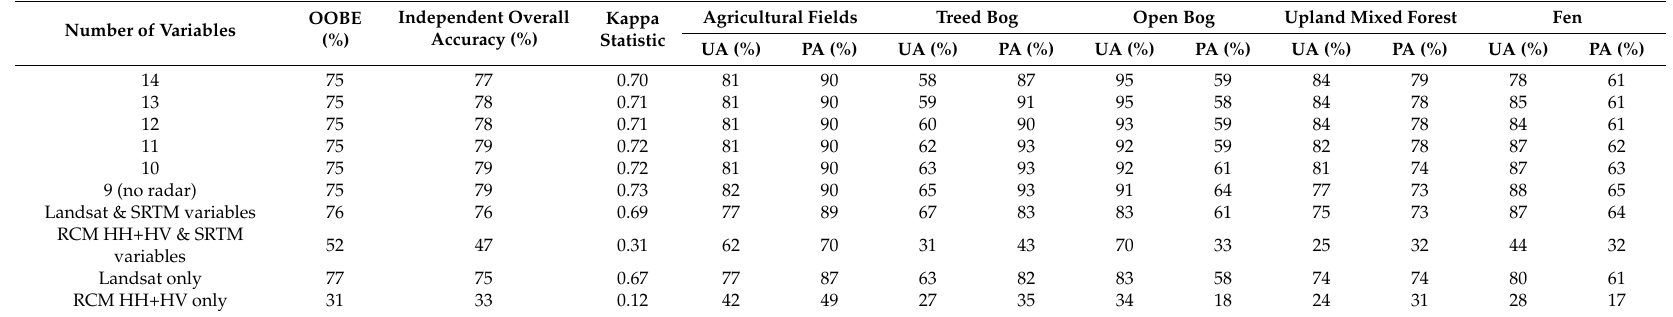
Table A11. Statistical results from the RCM Dual Pol HH+HV NESZ − 19 dB (13 July 2014), Landsat-8 (27 June 2014), SRTM variables summer model. The first iteration was run with all 14 variables, and variables ranked to be unimportant were then removed until 9 variables remained. The final variables in the model with the highest independent overall accuracy (10 variables) in order of decreasing importance were the seven Landsat-8 bands, HV Intensity, SRTM DEM, and SRTM slope. OOBE Number of Variables